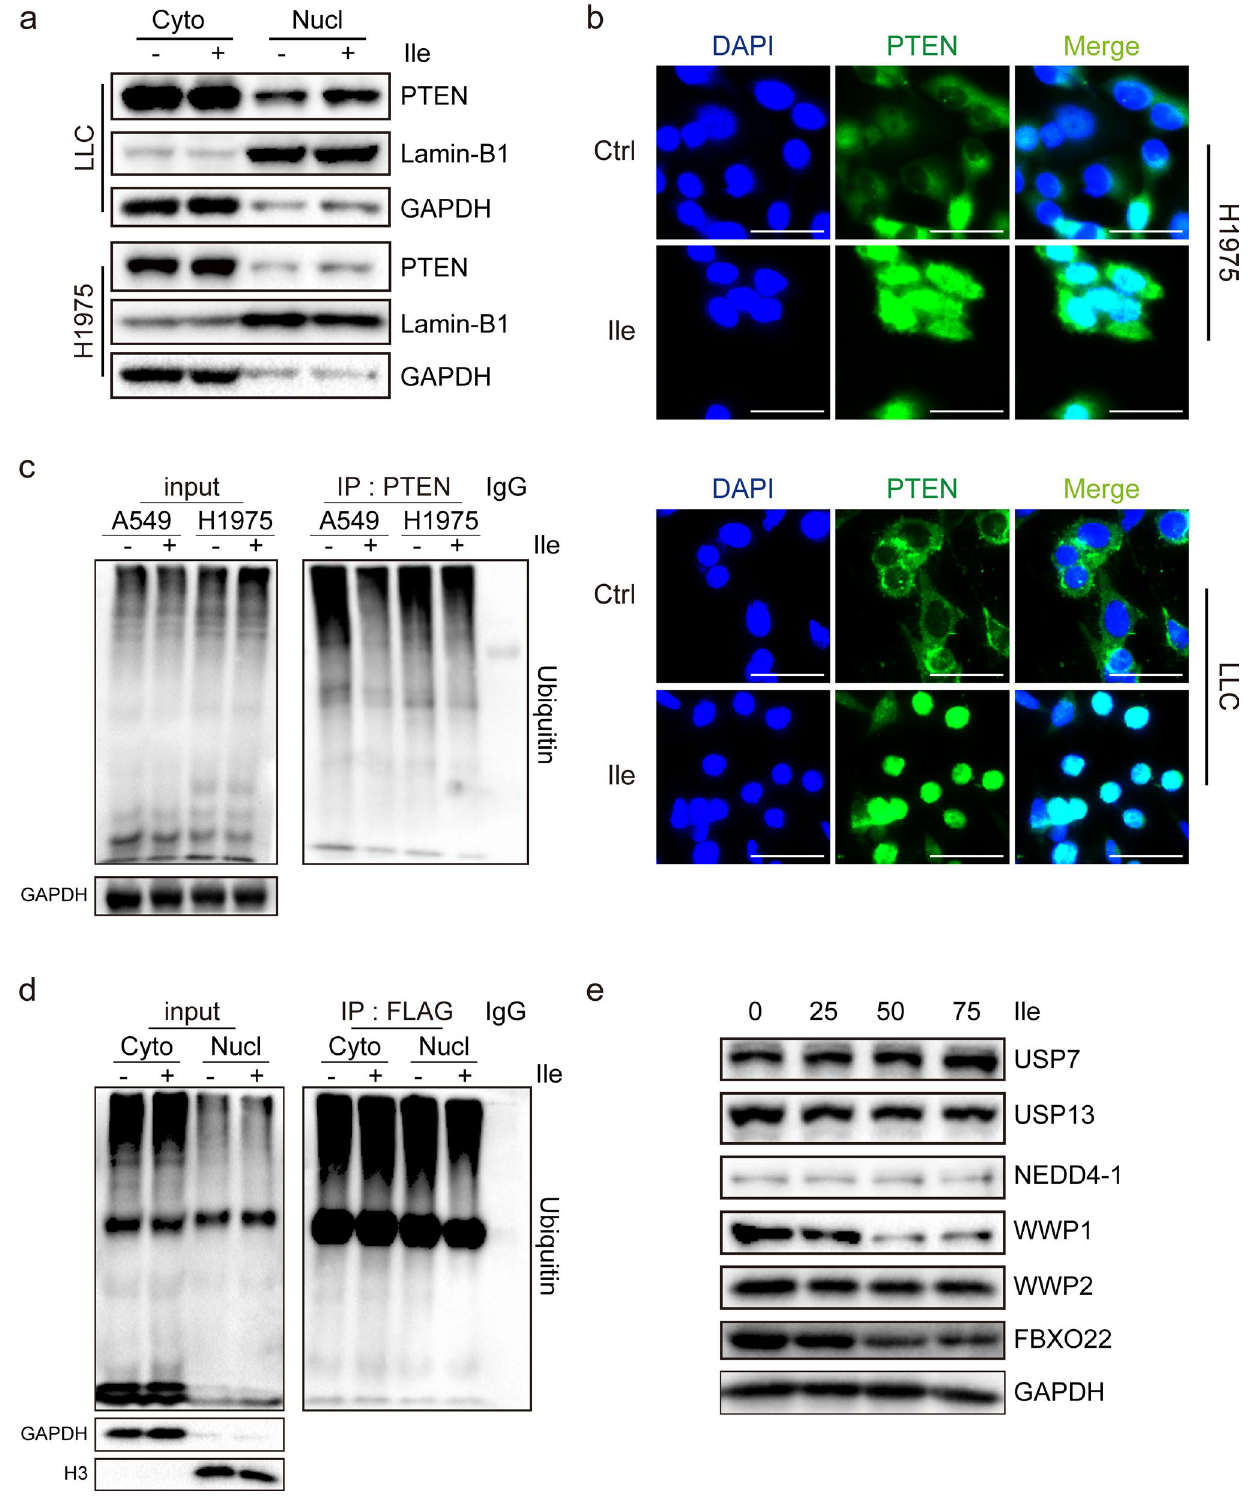
Fig. 4 Isoleucine promotes the stability of nuclear PTEN based on the PTEN nuclear accumulation. a LLC cells and H1975 cells were treated with 50 × isoleucine for 48 h and subjected to Western blot analysis after extraction of cytoplasmic (Cyto) and nuclear (Nucl) proteins (n = 3); b PTEN immunofluorescent stain- ing in H1975 cells and LLC cells, scale bar represents 50 μm (n = 3); c A549 cells and H1975 cells were treated with 50× isoleucine for 48 h and subjected to immunoprecipitation with an anti-PTEN antibody, followed by Western blot analysis with ubiquitination antibodies as indicated (n = 3); d Stably overexpressed Flag-PTEN A549 cells were treated with 50 × isoleucine for 48 h and cytoplasmic (Cyto) and nuclear (Nucl) proteins were immunoprecipitated with anti-Flag antibody followed by Western blot analysis using ubiquitination antibody (n = 3); e A549 cells were treated with different concentrations of isoleucine for 48 h, and related proteins involved in PTEN ubiquitination were analyzed by Western blot (n =